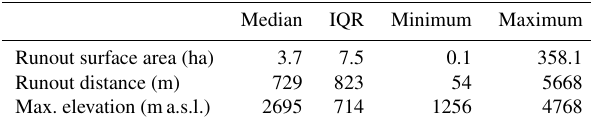
Table 1. Runout characteristics of the debris-flow